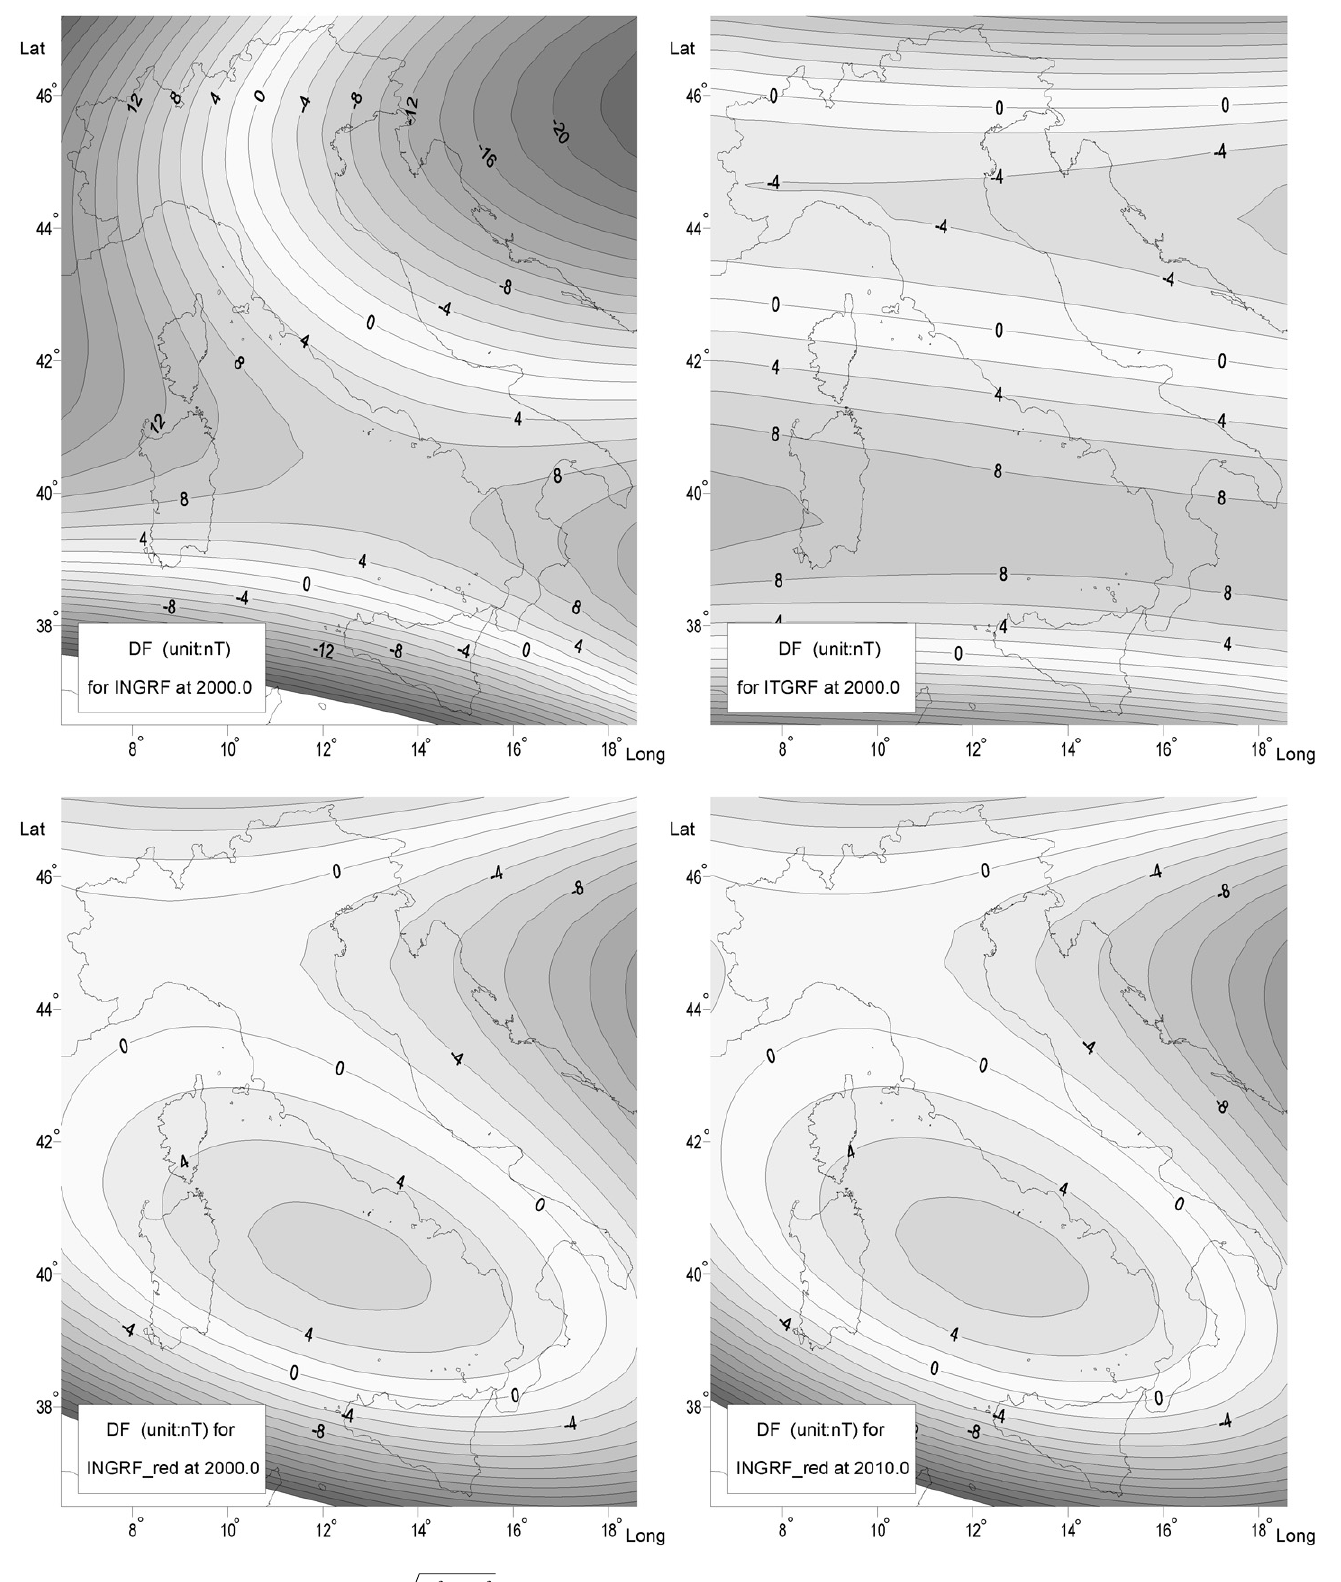
Figure 6. Geometrical condition for the normal fields INGRF and ITGRF at epoch 2000.0 and for normal field INGRF_ reduced, at epochs 2000.0 and